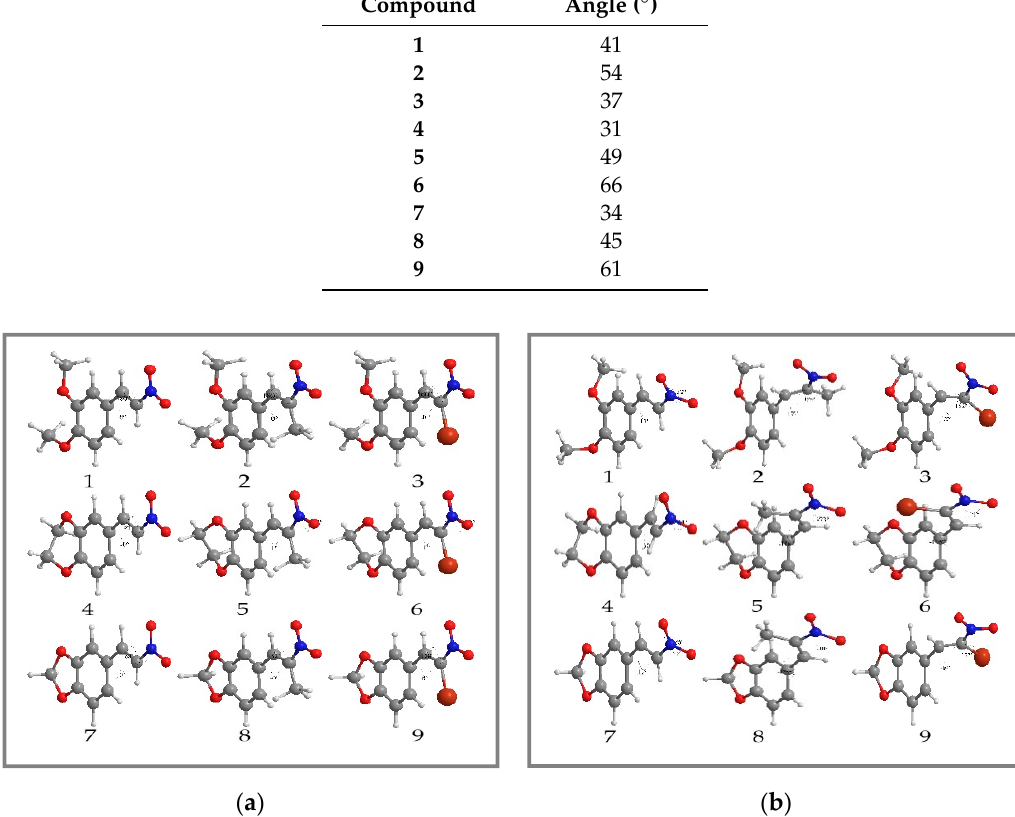
Table 6. Dihedral angles of the nitro group relative to the benzene calculated using Chem3D Ultra 10.0.